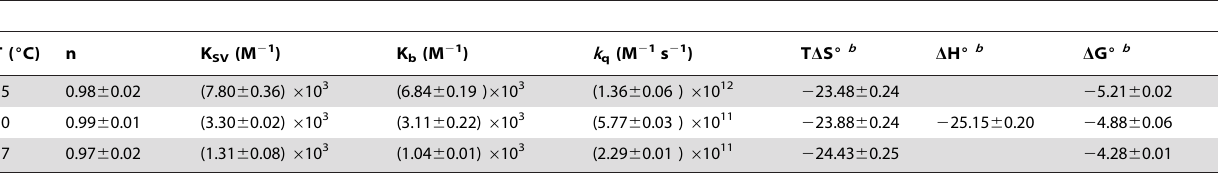
Table 1. Binding and thermodynamic parameters of HSA-HA at different temperature obtained from fluorescence quenching experiments a .